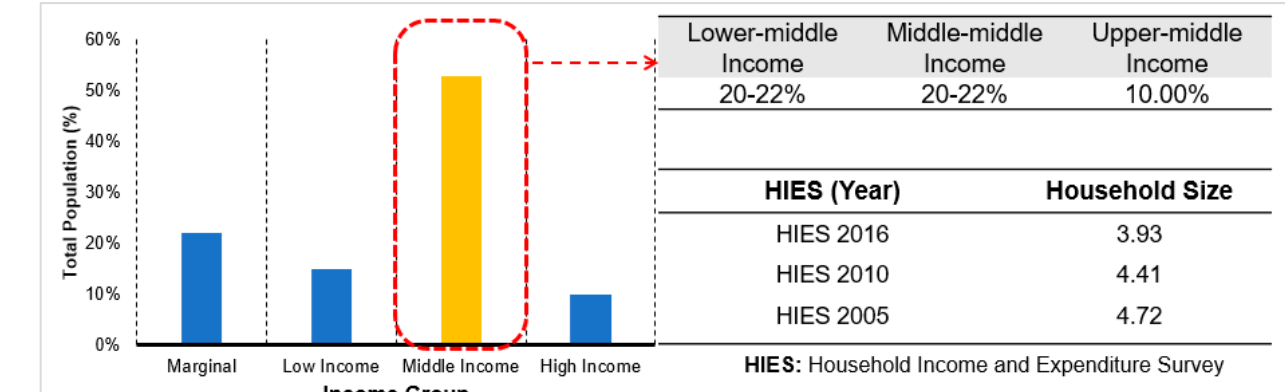
Survey (HIES) in Bangladesh by 2005, 2010 and 2016, the urban household size (e.g., fam- ily members) gradually decreased because of their socioeconomic limitations (e.g., monthly income) (Figure 1) [8,28].